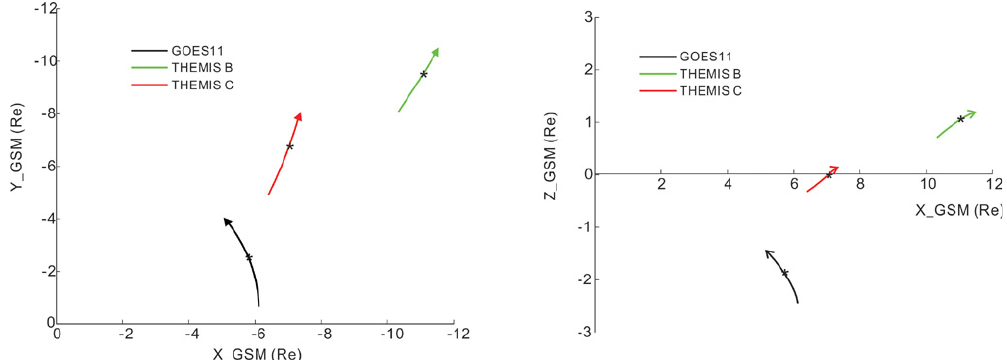
Fig. 1b. GOES 11, THEMIS B, and THEMIS C orbits in GSM coordinate between 09:00UT and 11:00UT on 5 December 2008. The arrows show the moving direction of the satellites. * represents the location of the satellites at